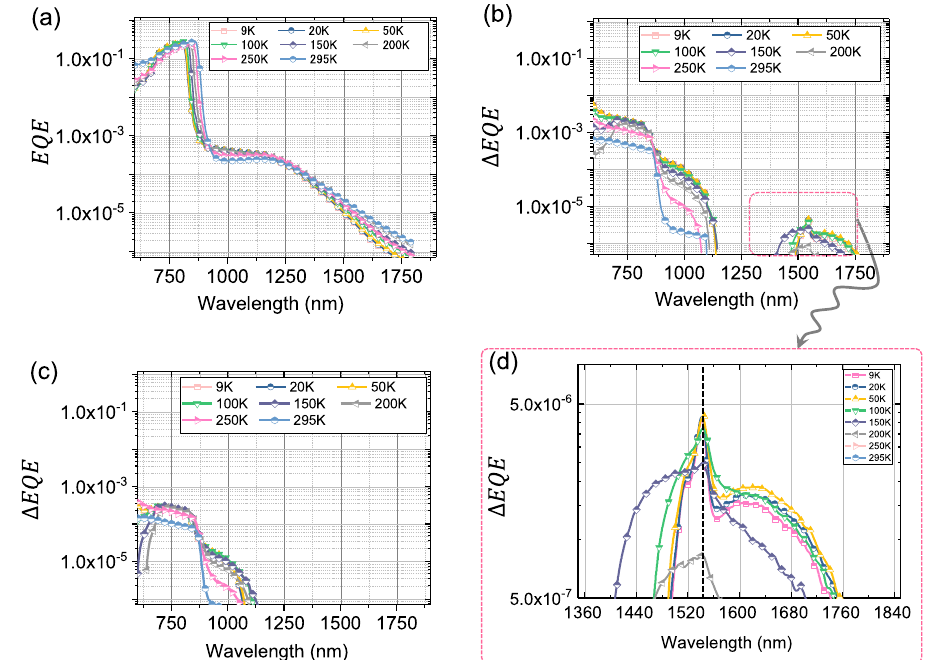
Fig. 5 Temperature dependence of the external quantum ef fi ciency (EQE) and differential external quantum ef fi ciency ( Δ EQE) spectra. a The temperature dependence of EQE, b the temperature dependence of Δ EQE obtained from the Er900 sample with a 1340-nm long-pass fi lter, c the temperature dependence of Δ EQE obtained from the Er900 sample with a 1550-nm long-pass fi lter, and d the magni fi cation of Er 3 + -induced Δ EQE signal around 1540 nm under 1340-nm long-pass fi lter as of b , respectively.